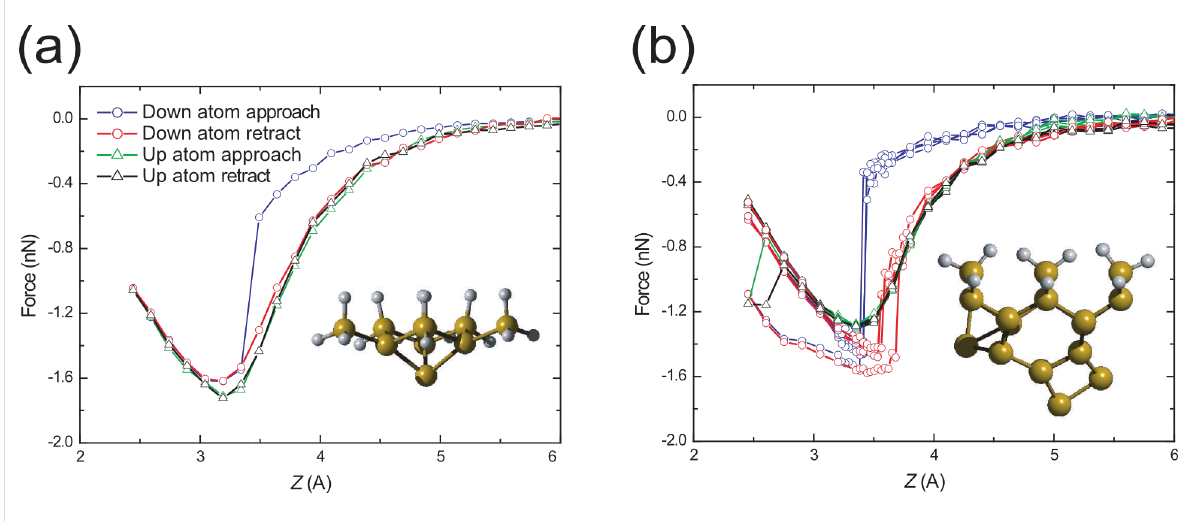
Figure 2: Simulated F ( z ) curves for the (a) H3 and (b) D 1 tip structures taken above the up (green and black triangles) and down (red and blue circles) atoms of a surface Si(100) dimer. Curves in (b) of the same colour correspond to the different orientations of the tip with respect to the surface dimer as described in Figure 1b. It can be seen that the D 1 tip shows little variation upon rotation around the surface normal axis. The H3 tip contains a symmetric apex and does not produce variation when rotated, therefore only a single rotation is shown.